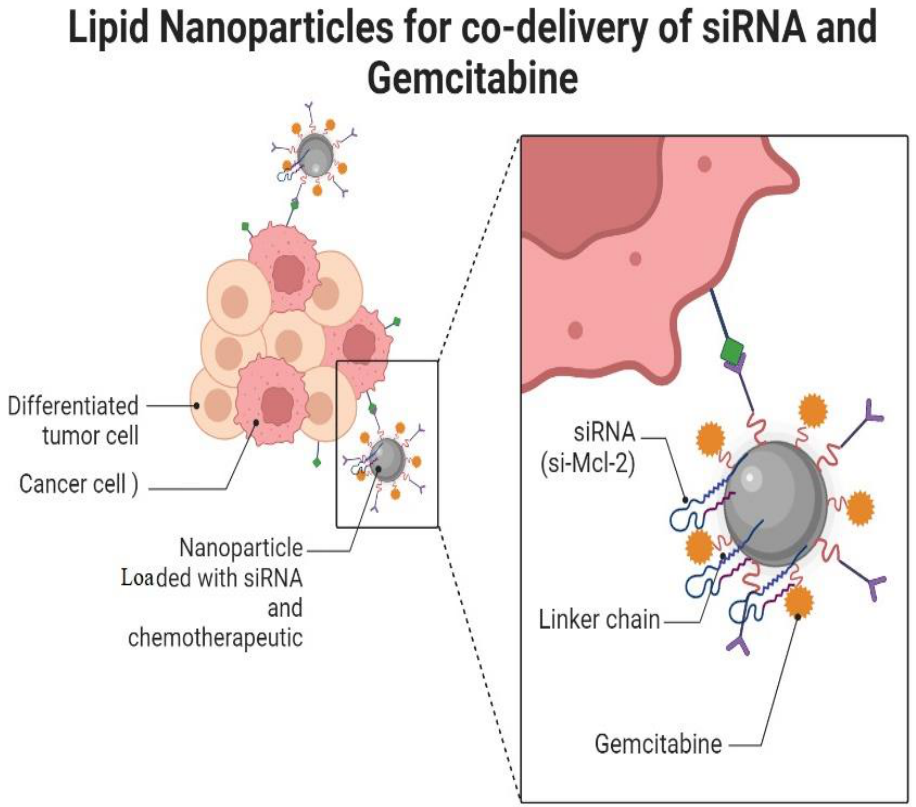
Figure 2. Nanoparticle-based delivery of siRNA and gemcitabine functionalized with targeting moiety, which delivers drug and Mcl-2 siRNA to cancer cells and helps to combat resistance.